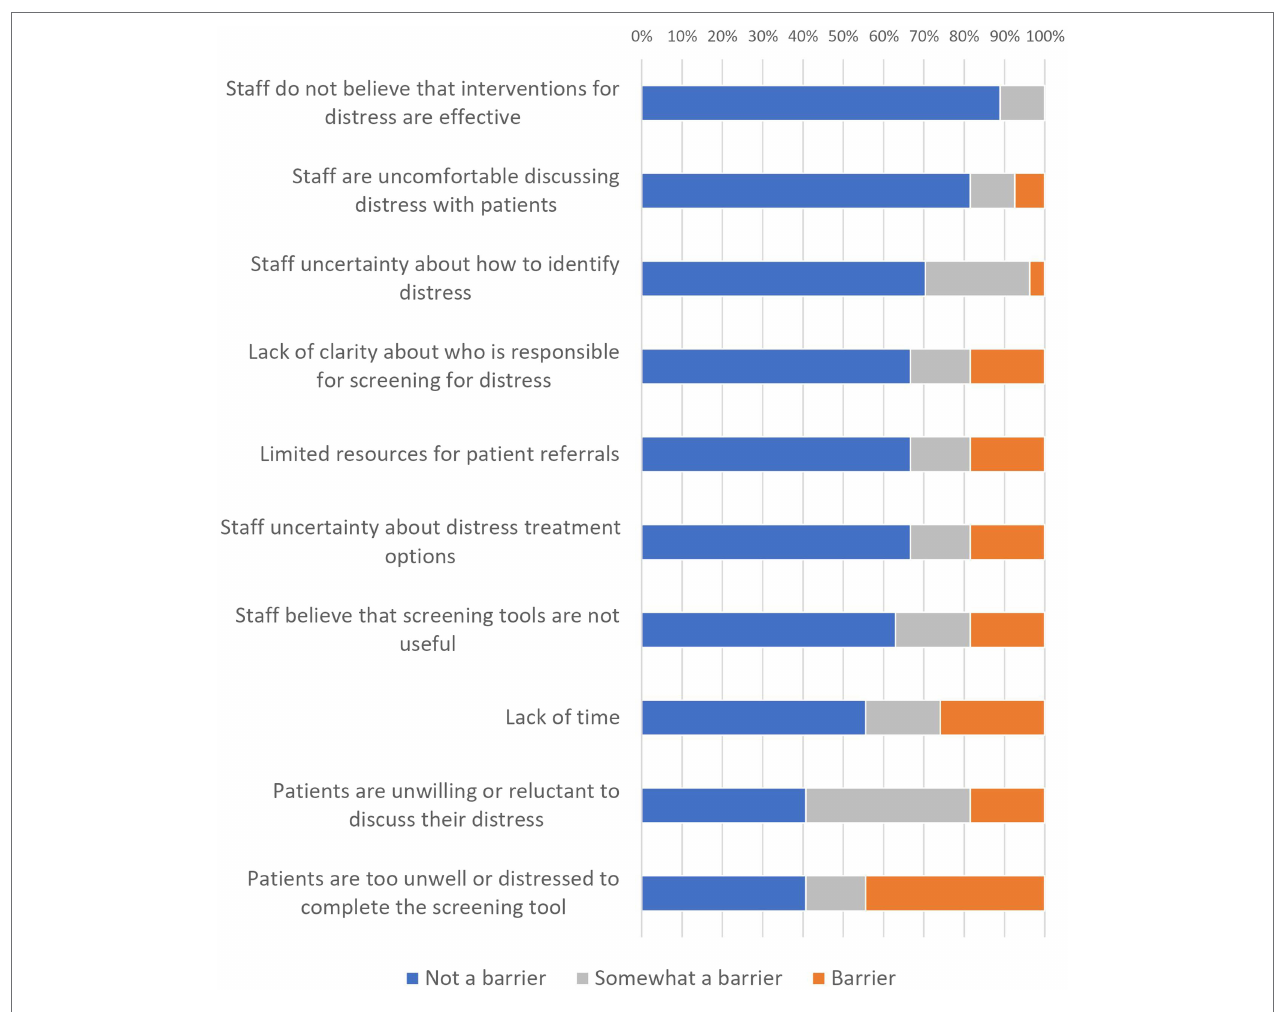
FIGURE 4 | HCP ratings of barriers to use of the